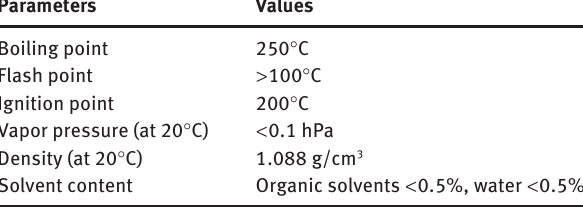
Table 3 The properties of ink